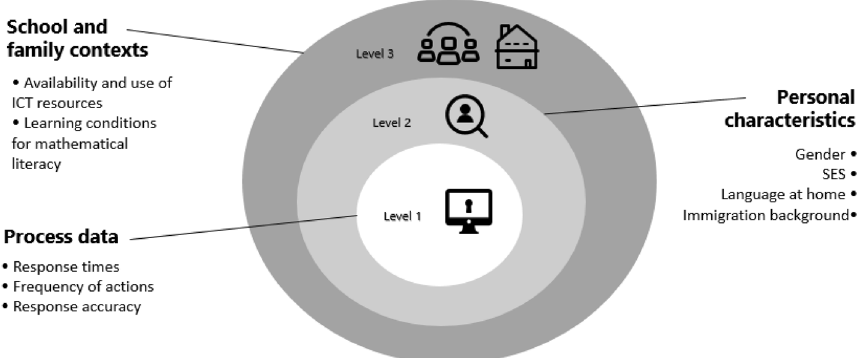
Fig. 2 Framework for the analysis of process data and contextual